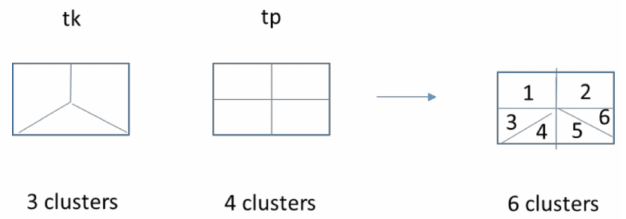
Figure 11. Illustration of clustering combinations.